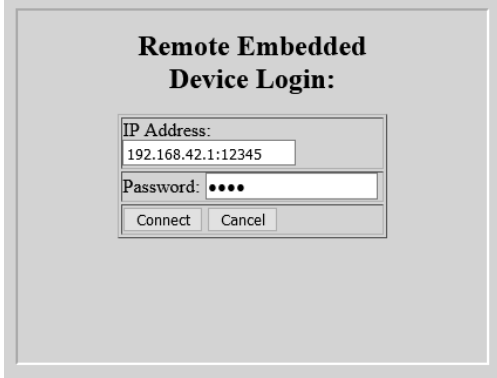
Figure 11. IOPT debugger tool connection